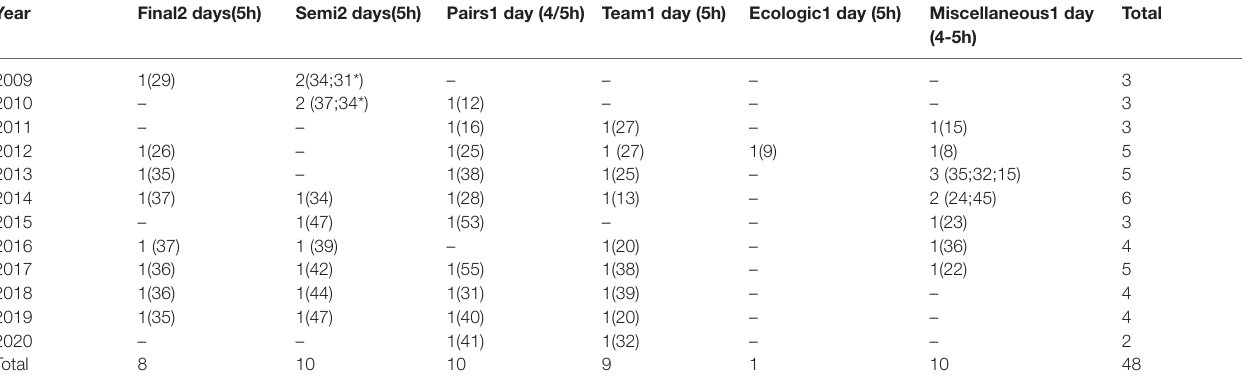
Number of tournaments for each year are reported together with the number of participants between parenthesis. *Indicates that in 2009 and 2010 there were two semi-finals of the individual league (i.e., North and South), but since 2011 only one semi-final was organized comprising both North and South. In miscellaneous tournaments participants can represent individuals, pairs of